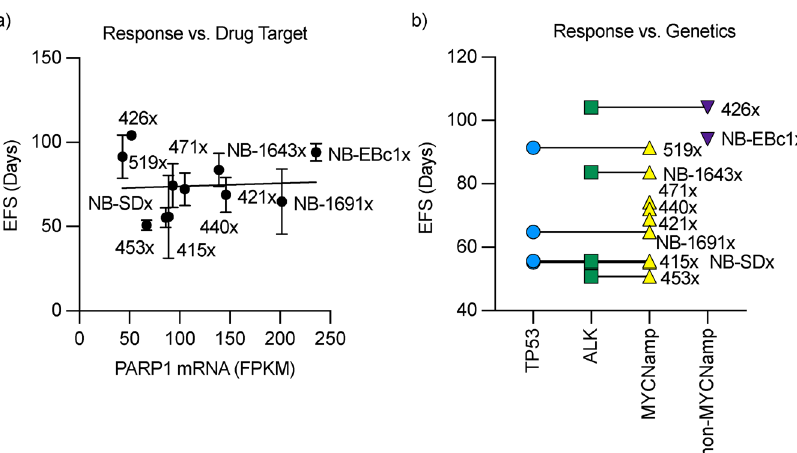
Fig. 2 Testing for contributing factors of [ 211 At]PTT response. a Linear regression plot for EFS vs. PARP1 mRNA ( p value = 0.8). b Grouped response for genetic signatures in PDX models. Lines represent models with 1 or more genetic